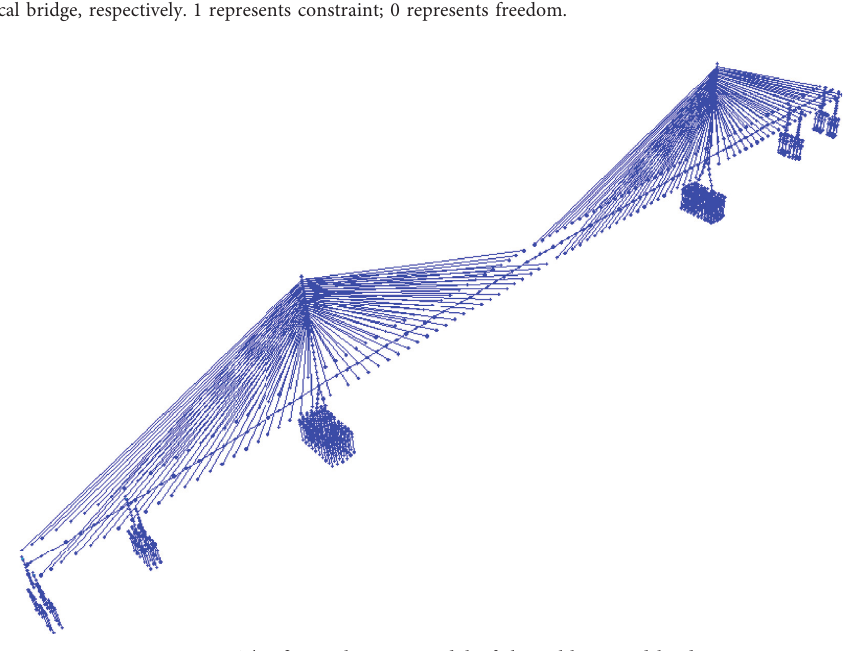
Figure 6: The finite element model of the cable-stayed